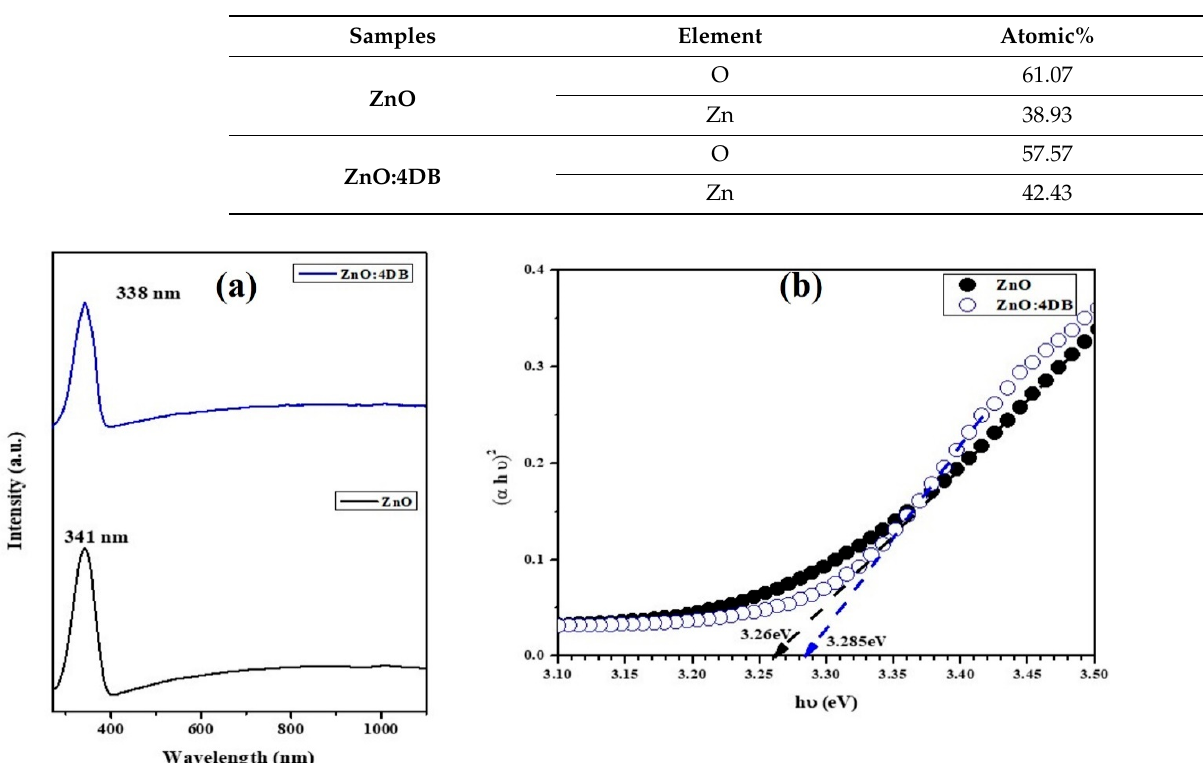
Figure 4. ( a ) UV–Vis–NIR absorbance spectra of the pure ZnO NPs and ZnO:4DB NPs; ( b ) plot of ( α h υ ) 2 vs. photon energy h υ of the pure ZnO NPs and ZnO:4DB NPs. ( α h υ ) 2 vs. photon energy h υ of the pure ZnO NPs and ZnO:4DB